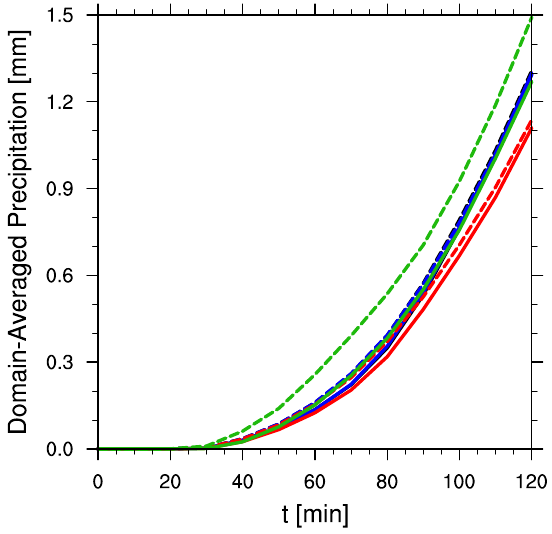
Fig. 2. Domain-average cumulative precipitation. Depicted here are the “Clean” (solid) and “Polluted” (dashed) aerosol scenarios for simulations using the baseline initial conditions. All four model configurations are presented, i.e., bin (green), bulk-explicit (black), bulk-cond (blue), and bulk-original